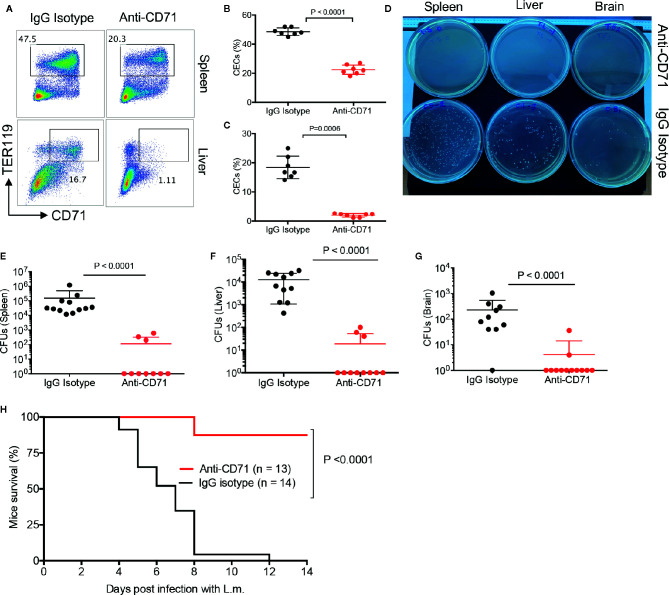
The depletion of CECs reduces bacterial load in tissues. (A) Representative plots and (B) and (C) cumulative data showing quantification of CECs in the spleen and liver of mice following anti-CD71 or IgG2a isotype control administration (i.p.) at days 4 and 5, measured 2 days later. (D) Representative L.B plates comparing bacterial colonies in anti-CD71 treated versus IgG2a isotype control treated mice. (E) Cumulative data of Listeria monocytogenes colony forming units (CFUs) in the spleen, (F) liver, and (G) brain of mice either treated with anti-CD71 antibody or IgG2a isotype control. (H) Survival for neonate mice either treated with isotype control or anti-CD71 at days 4 and 5 then orally administered with 1 × 107 CFUs Listeria monocytogenes at day 6, and monitored over 2 weeks. Differences in mean values analyzed by two-tailed Student’s t test; p value is shown; N > 7/group, from at least two experiments.